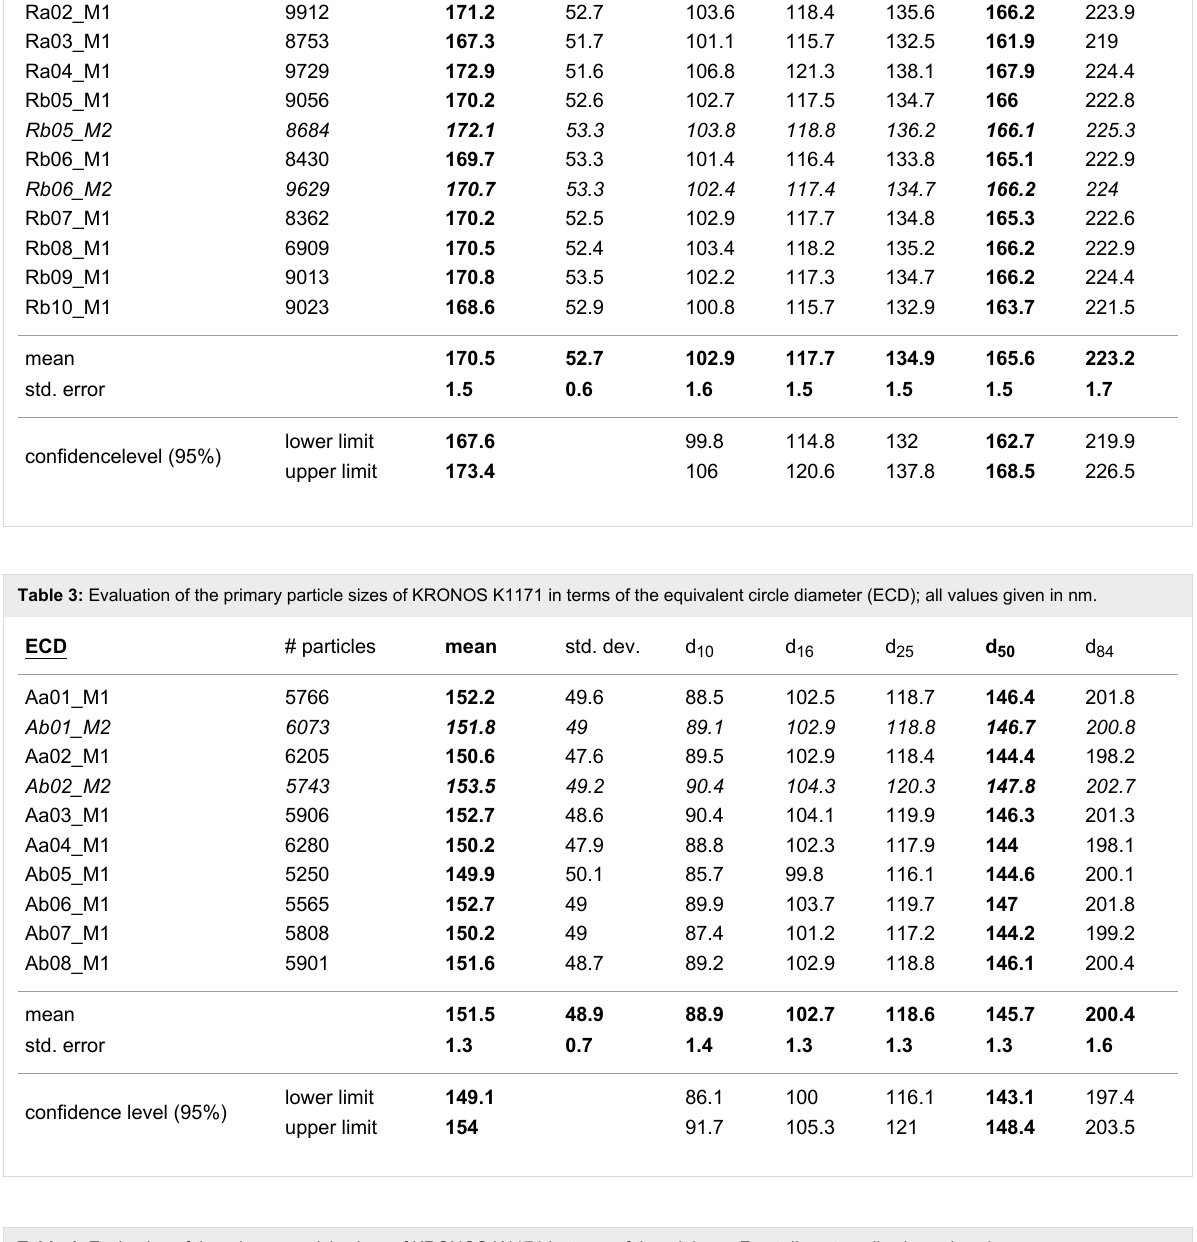
Table 2: Evaluation of the primary particle sizes of KRONOS K2360 in terms of the minimum Feret diameter; all values given in nm. min. Feret # particles